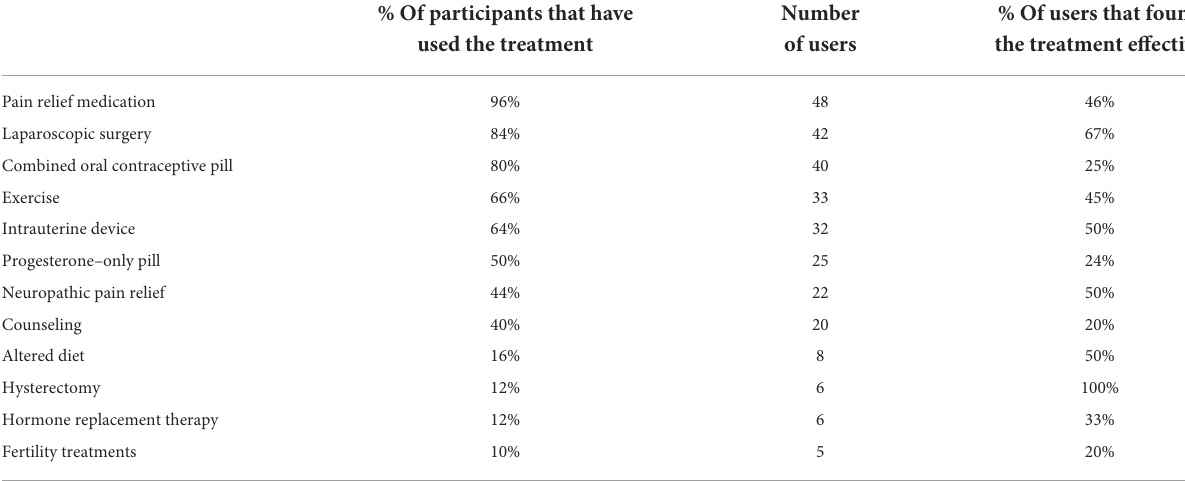
% Of participants that have used the treatment